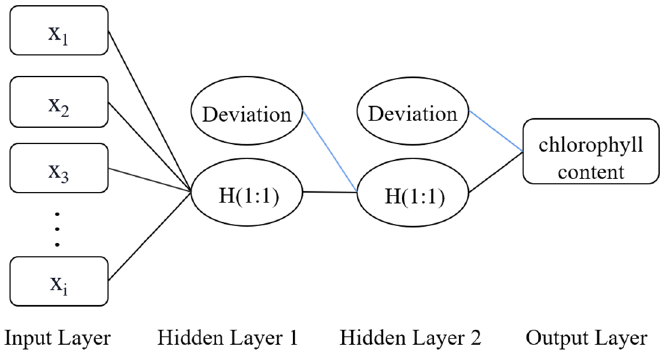
Figure 2. Multilayer perceptron network (MLP) topology used in this